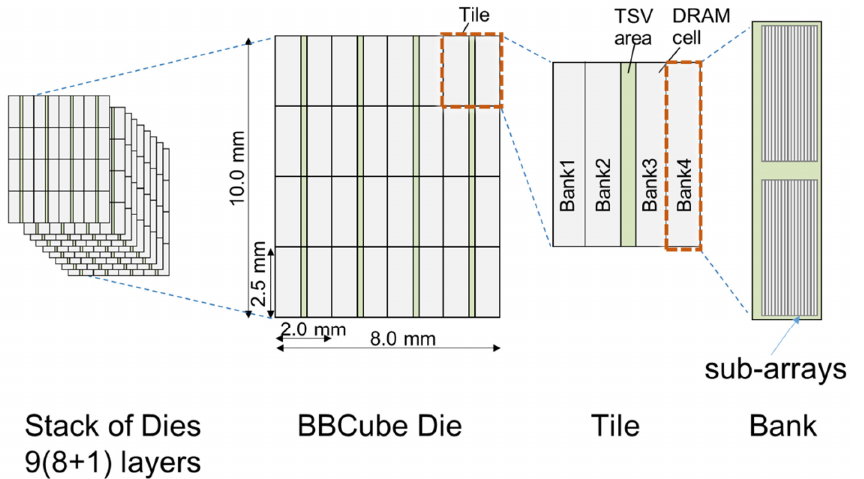
Figure 46. Configuration and structural hierarchy of the stacked DRAM system, BBCube. Banks consisted of sub-arrays for 2D redundancy, and stacked dies of 9 layers for 3D redundancy are illustrated.